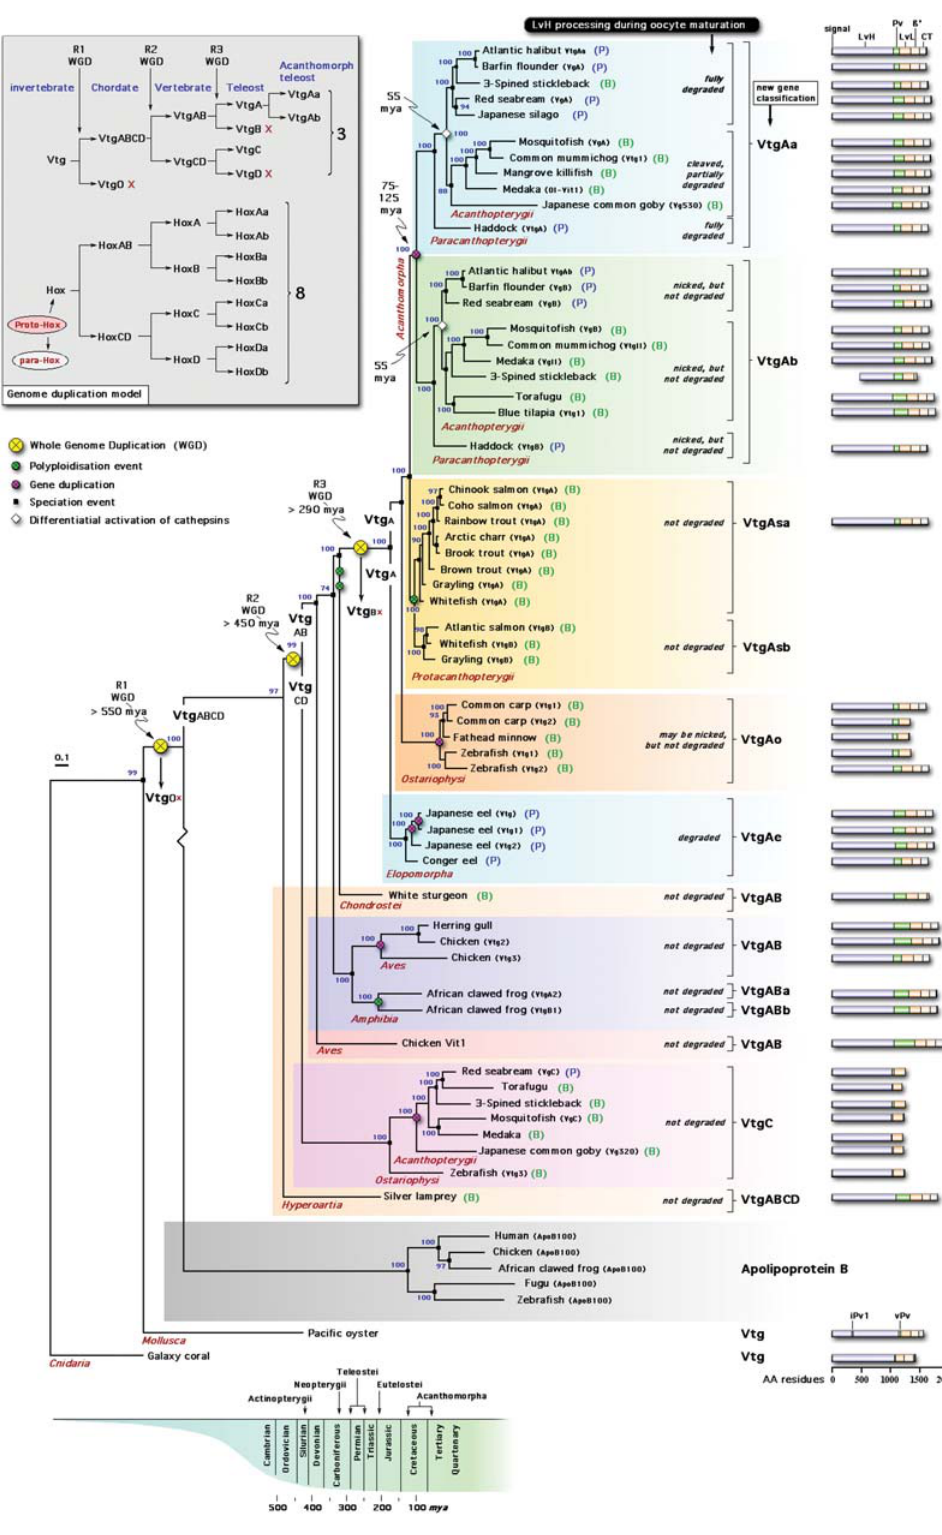
Figure 1. Bayesian majority rule consensus phylogenetic tree for the amino acid alignment of vertebrate large lipid transfer modules rooted with galaxy coral. Numbers beside nodes indicate posterior probabilities (consensus of 6,500 trees from 650,000 generations). See methods for further details of phylogentic analyses and supplementary material (Table S1) for accession numbers. Schematic linear scale representations of the structure of the vitellogenin genes are drawn for each taxa with complete sequences in the databanks. Sub-domain structures were identified from conserved cleavage sites. The iPv1 of Pacific oyster is proposed to be the origin of the first polyserine domain in the vitellogenins of insects. The geological scale provides an estimate of the divergence of the genes. Since the Vtg genes were not clock-like, this scale is approximate. See text and Fig. 2 for an explanation of the gene duplication model. X=gene lost; (P)=pelagic egg; (B)=benthic egg. doi:10.1371/journal.pone.0000169.g001 PLoS ONE |